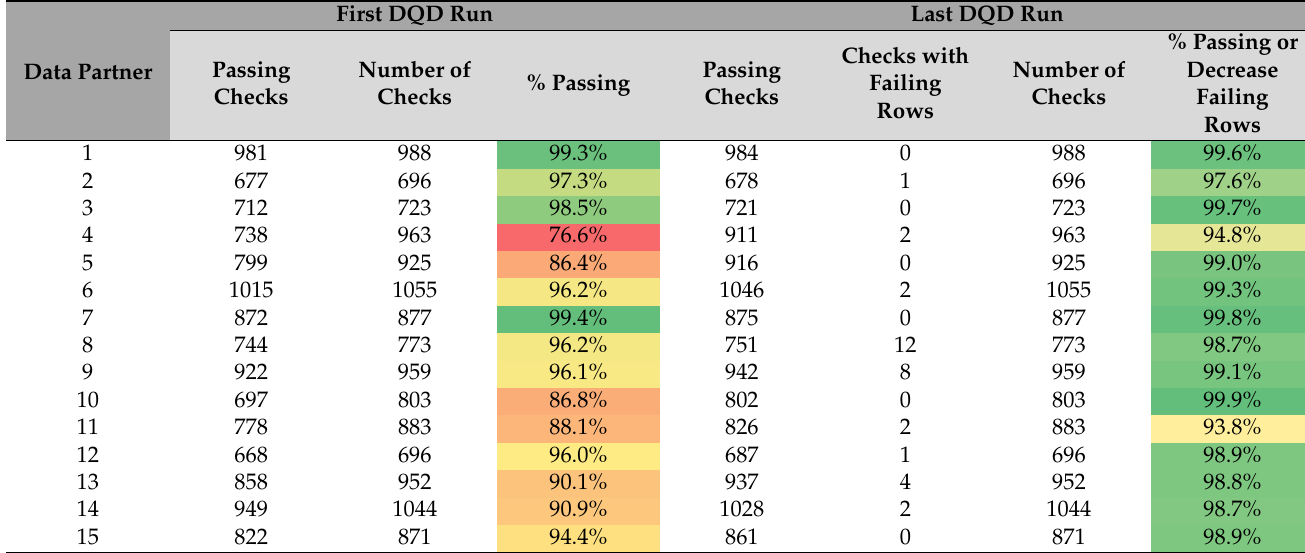
Table 2. The proportion of data quality checks that either passed or reduced failing rows between the first and last run of Data Quality Dashboard (DQD), by Data Partner (DP), for checks in common between the two.